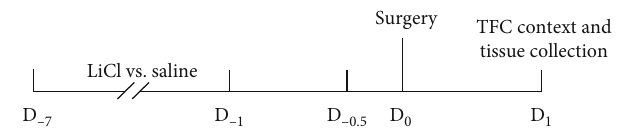
Figure 1: Study design. The aged rats were divided into four groups and received the lithium or saline treatment for 7 consecutive days. Then, the rats in the appropriate group received the tibia fracture surgery. The TFC training was performed 30min before surgery. The brain tissues and serum samples were collected 24h after surgery. Behavioral tests were also performed at this time